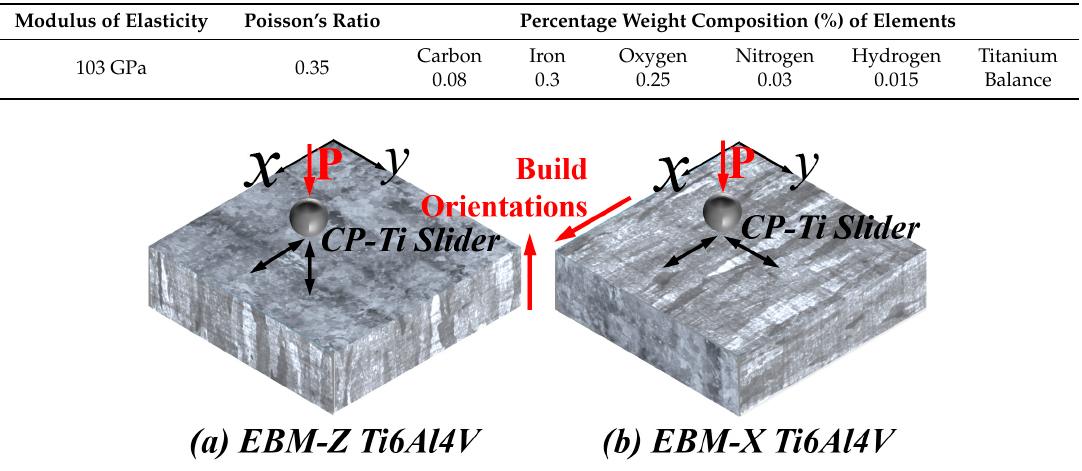
Figure 3. Illustration of slider motions of fatigue wear test on ( a ) EBM-Z and ( b ) EBM-X